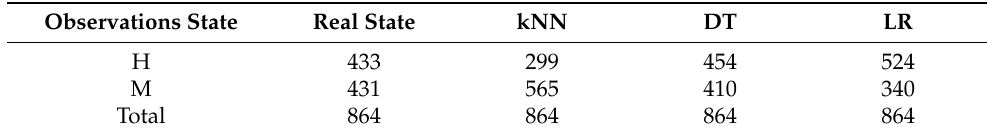
Table 7. Prediction results for application case 2.